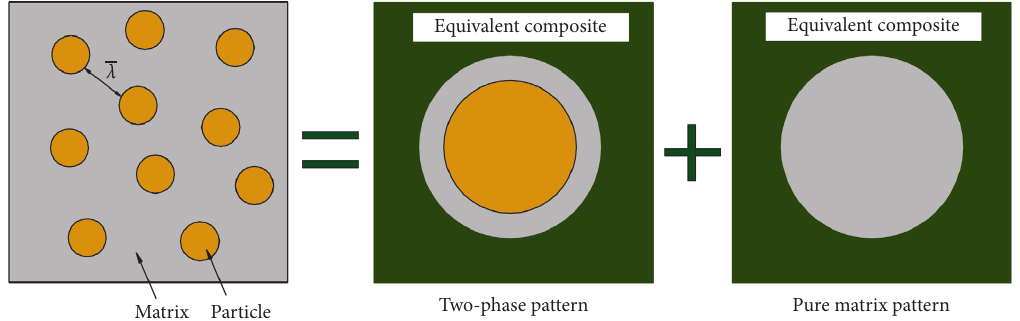
Figure 1: MRP model.